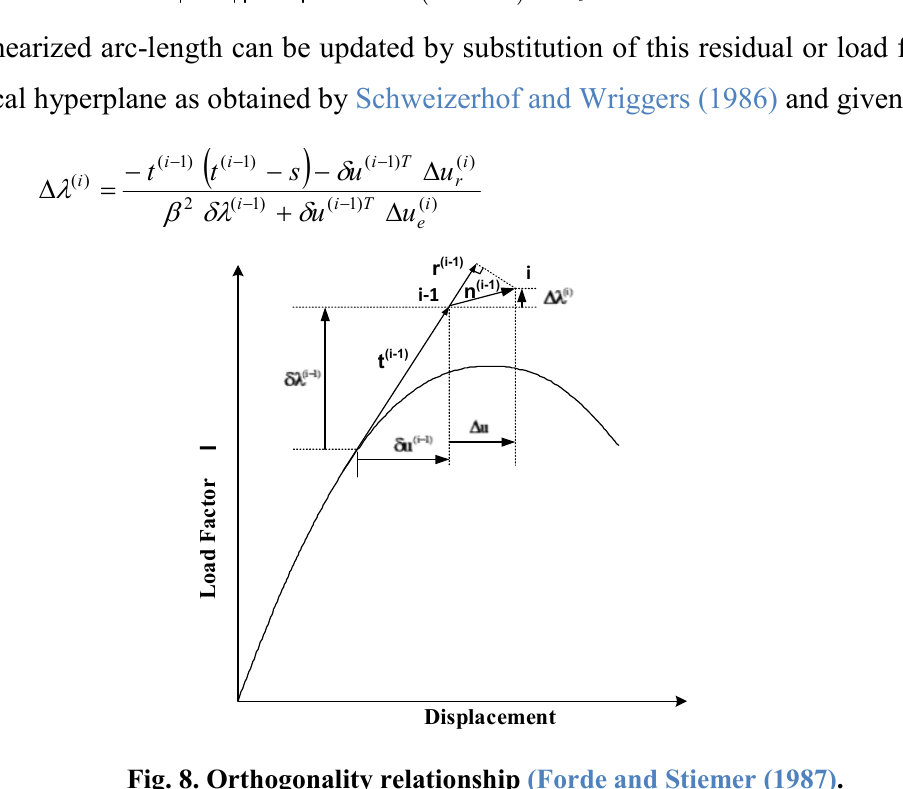
Fig. 8. Orthogonality relationship (Forde and Stiemer